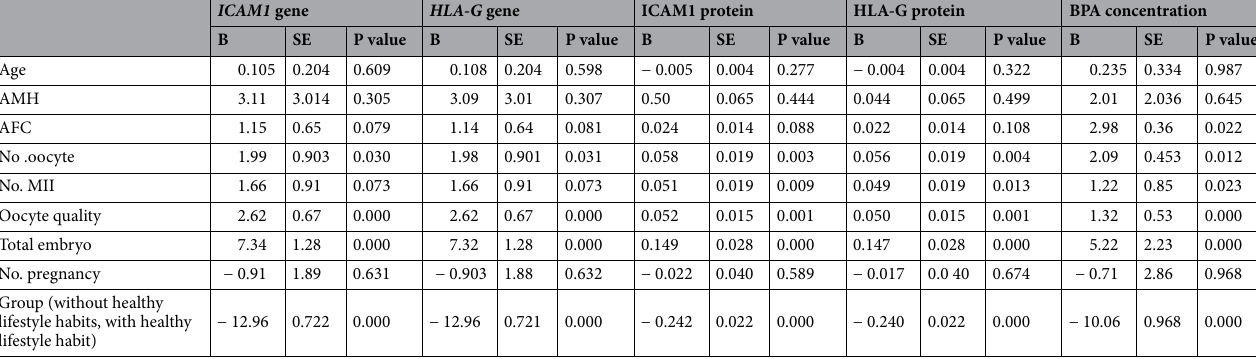
Table 3. Univariate regression analysis for factors associated with ICAM1and HLA-G genes, proteins and DNA methylation. B: unstandardized coefficient; SE: standard error; AFC: antral follicular count; AMH: anti Müllerian